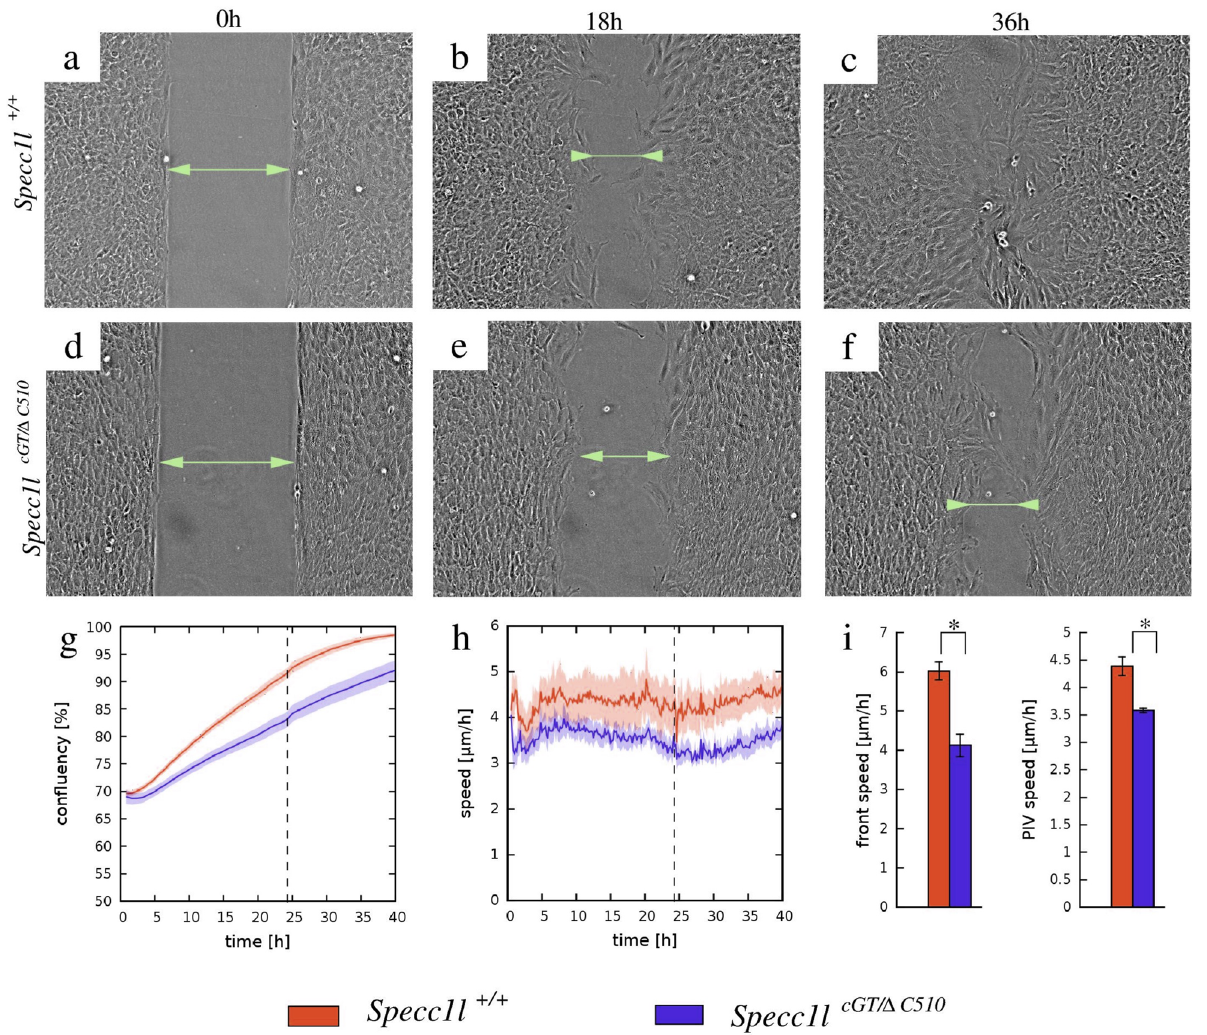
Figure 3. Specc1l cGT/ΔC510 primary MEPM cells exhibit migration defects in wound-repair assays. ( a – f ) Phase contrast micrographs of a representative wound-repair assay performed with wild-type (WT) and Specc1l - mutant MEPM cells. While WT cells ( a – c ) show complete wound-closure by 36 h (h), the mutant cells ( d – f ) require more time. The wound area is indicated by two-headed arrows. ( g ) Automated confluence analysis of wound-repair experiments quantified the average percentage of wound-closure over time. Orange and blue colors indicate data obtained from WT and mutant cultures, respectively. By 24 h (dashed vertical line), WT MEPM cells close more than 66% of the wound. Solid lines represent the average of 29 independent microscopic fields, recorded in 5 independent experiments. Shaded areas indicate SEM. ( h ) Average cell motility speed, calculated by PIV analysis of the 29 wound-closure recordings analyzed in ( g ). For each time point velocity magnitudes within the entire cell-covered area were averaged. Despite approaching wound-closure after 24 h (dashed line), cells remained motile in both WT and mutant MEPM cultures. ( i ) Statistical analysis of data presented in ( g , h ) showed that the motility of mutant MEPM cells is significantly reduced in comparison to WT MEPM cells. Left: average speed of wound front, calculated within the 1–15 h time interval (p < 6.7 × 10 −6 , Welch’s t-test). Right: average speed of cell movements within the entire recorded time period of 40 h (p < 2.2 × 10 −5 , Welch’s t-test). Error bars represent